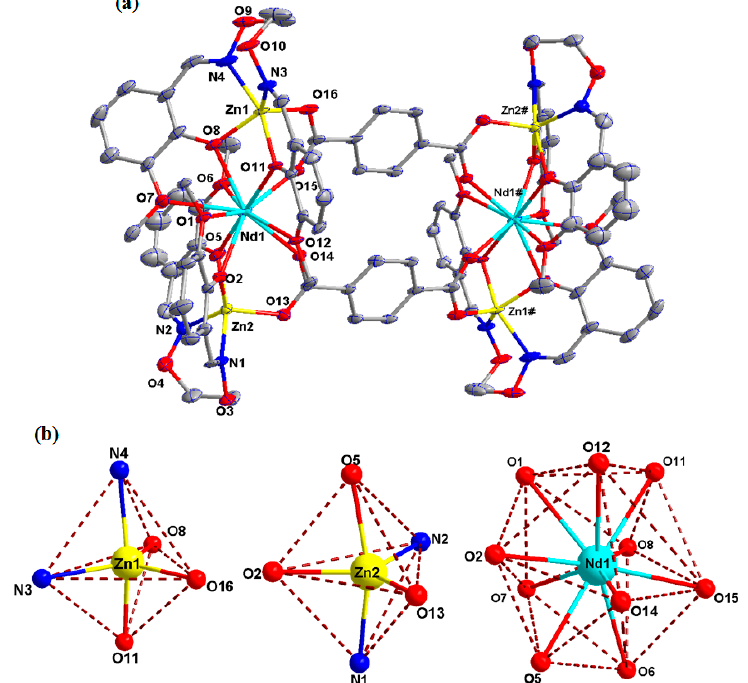
Figure 1. ( a ) Molecular structure and atom numberings of the Zn II -Nd III coordination compound (hydrogen atoms are omitted for clarity). ( b ) Coordination polyhedra of the Zn II and Nd III atoms.